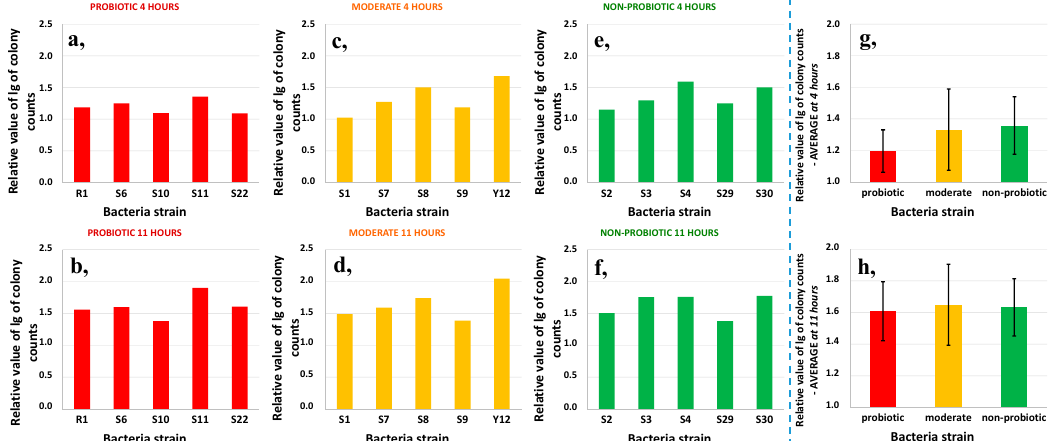
Figure 3. The relative colony counts from the initial 10 6 CFU / mL number for the tested 15 bacteria strains at 4 h ( a , c , e ) ( n = 15) and 11 h ( b , d , f ) ( n = 15) and the average values of the probiotic, moderately probiotic, and non-probiotic groups at 4 h ( g ) ( n = 45) and 11 h ( h ) ( n = 45) of fermentation in milk.